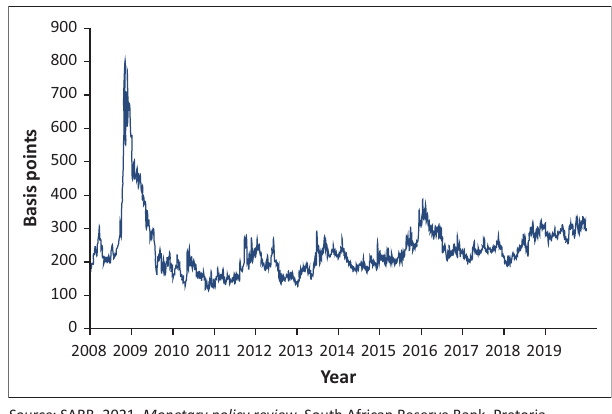
FIGURE 2: Risk premium (EMBI+).